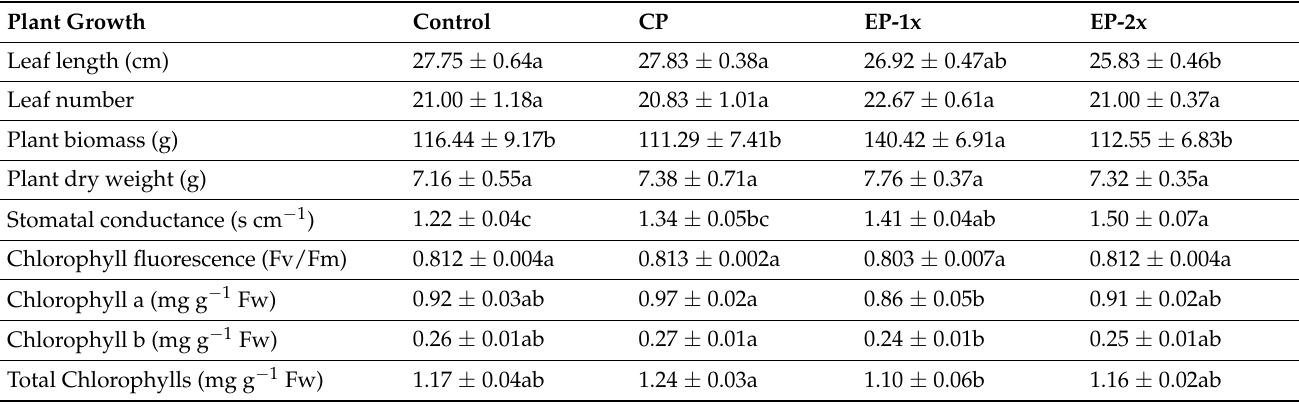
Table 1. Yield, plant growth, and physiological characteristics of lettuce plants in relation to foliar application of different